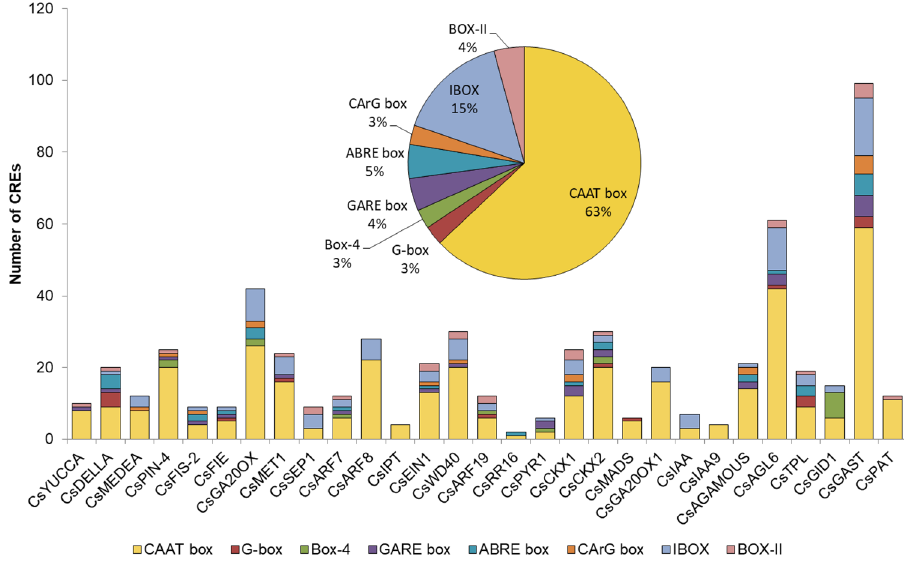
Figure 3. Distribution of various CREs on each gene (Insert: Abundance of each